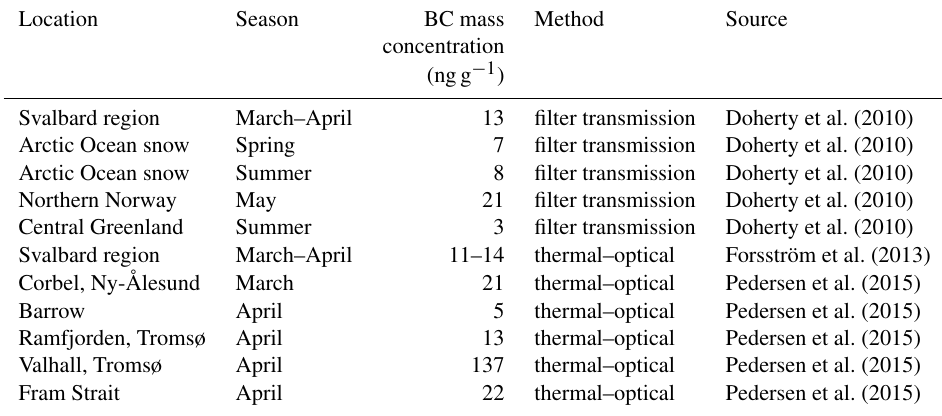
Table 1. Values of the black carbon mass concentration in snowpack observed in different regions and seasons in the Arctic. Note that Ped- ersen et al. (2015) and Forsström et al. (2013) derived the mass concentration of elemental carbon applying a thermal–optical measurement